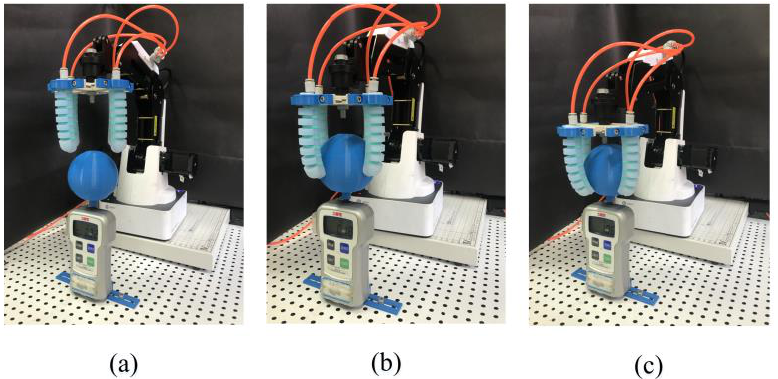
Table 3. The end-output force of fingertip grasping and envelope grasping.